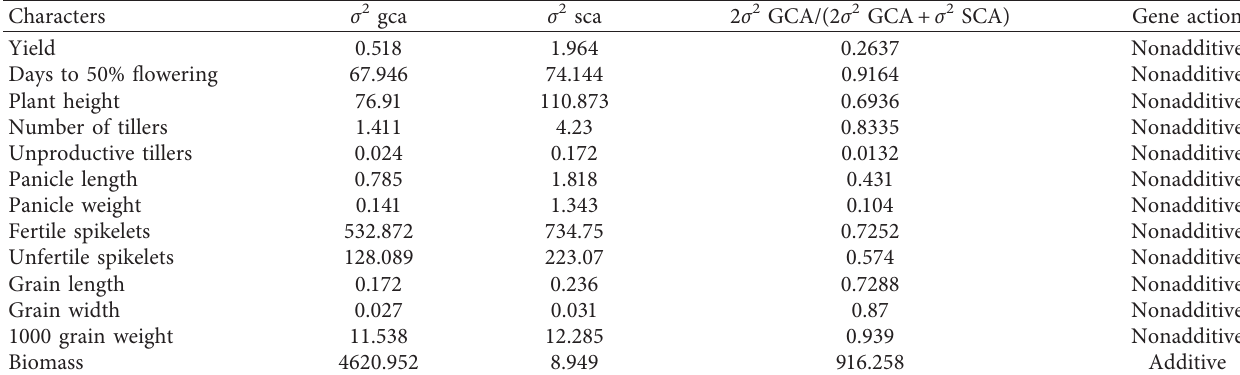
Table 5: Ratios of GCA variance to SCA variance for grain yield and agronomic traits at Bahari and KALRO Mtwapa during 2018 long rain